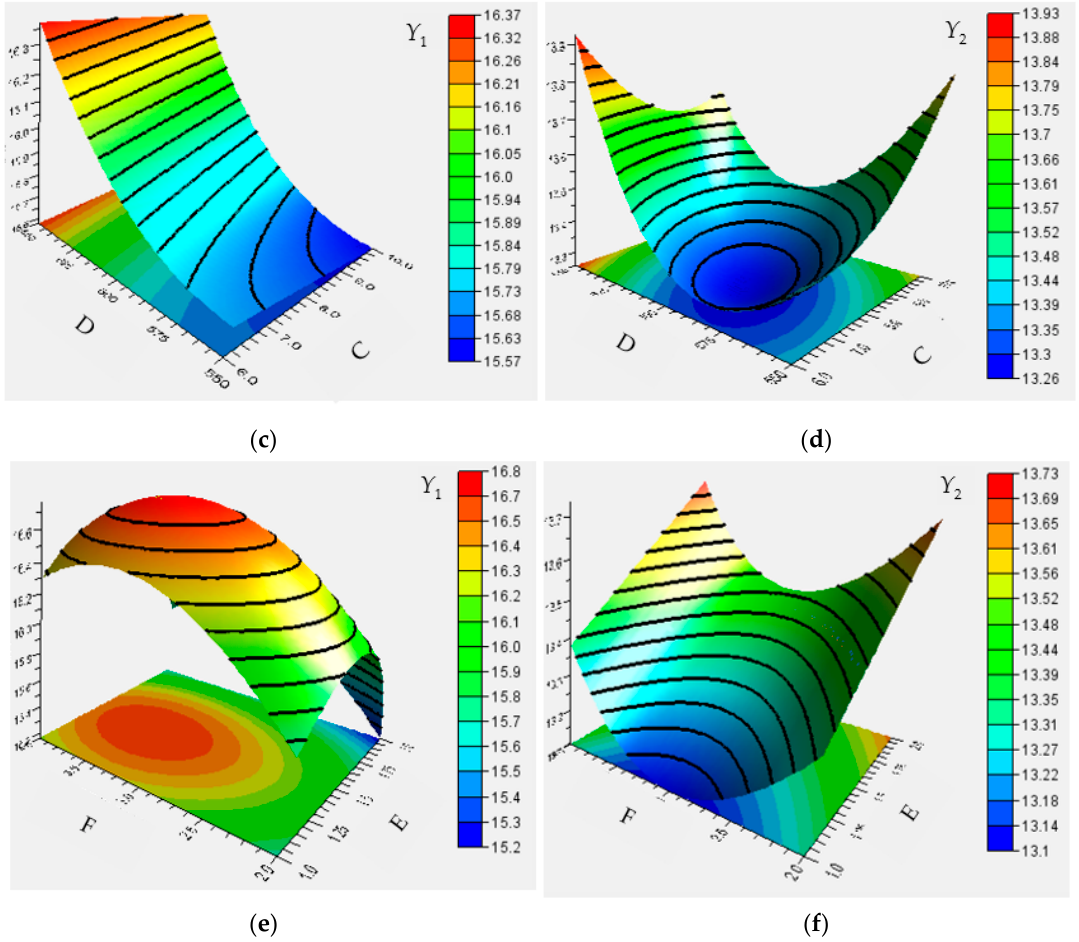
Figure 7. Interactive e ff ect of process parameters on thickness in slow cooling zone, ( a ) A and B on Y 1 , ( b ) A and B on Y 2 , ( c ) C and D on Y 1 , ( d ) C and D on Y 2 , ( e ) E and F on Y 1 , ( f ) E and F on Y 2 .